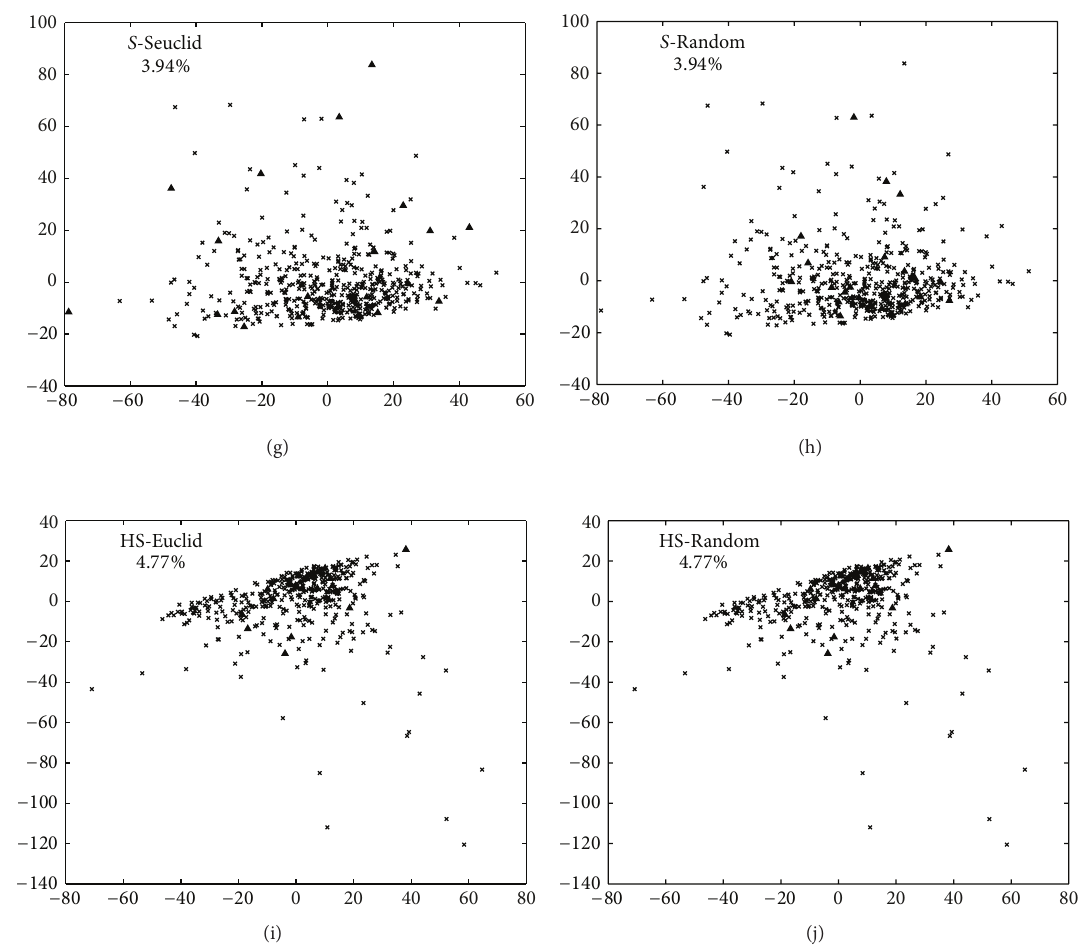
Figure 3: Principal component plots of core accessions and reserve accessions in the sampling percentage. The upward pointing triangles represented the core accessions; the crosses represented the reserved accessions. The left column showed plots for subcore collection constructed by LDSS method based on the selected genetic distance and sampling percentage; the right column showed plots for sub- core collection constructed by complete random selection based on the same sampling percentage. HR-Manhat, high resistant group combining Manhattan distance; 𝑅 -Euclid, resistant group combining Euclidean distance; MR-Mahal, moderate resistant group combining Mahalanobis distance; 𝑆 -Seuclid, susceptible group combining Standardized Euclidean distance; and HS-Euclid, high susceptible group combining Euclidean